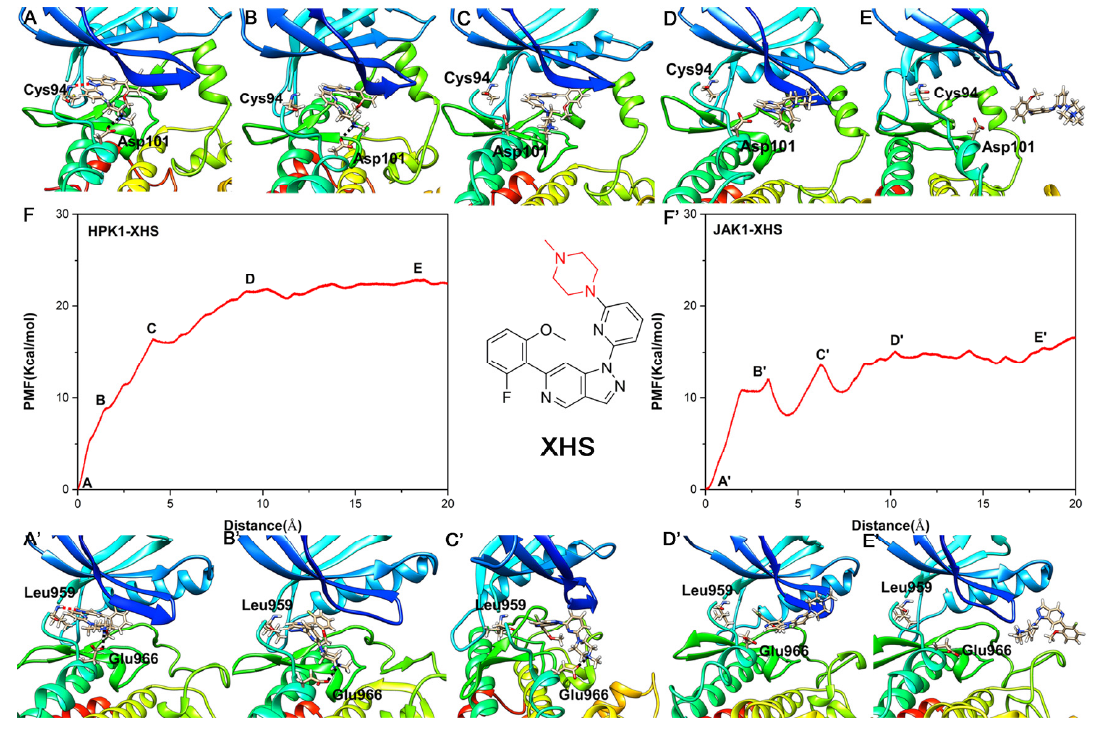
Figure 7. The unbinding process of inhibitor XHS dissociating from binding pocket of HPK1 kinase ( A – E ) and the corresponding PMF curve ( F ), the unbinding process of inhibitor XHS dissociating from binding pocket of JAK1 kinase ( A ’ – E ’) and the corresponding PMF curve ( F ’).